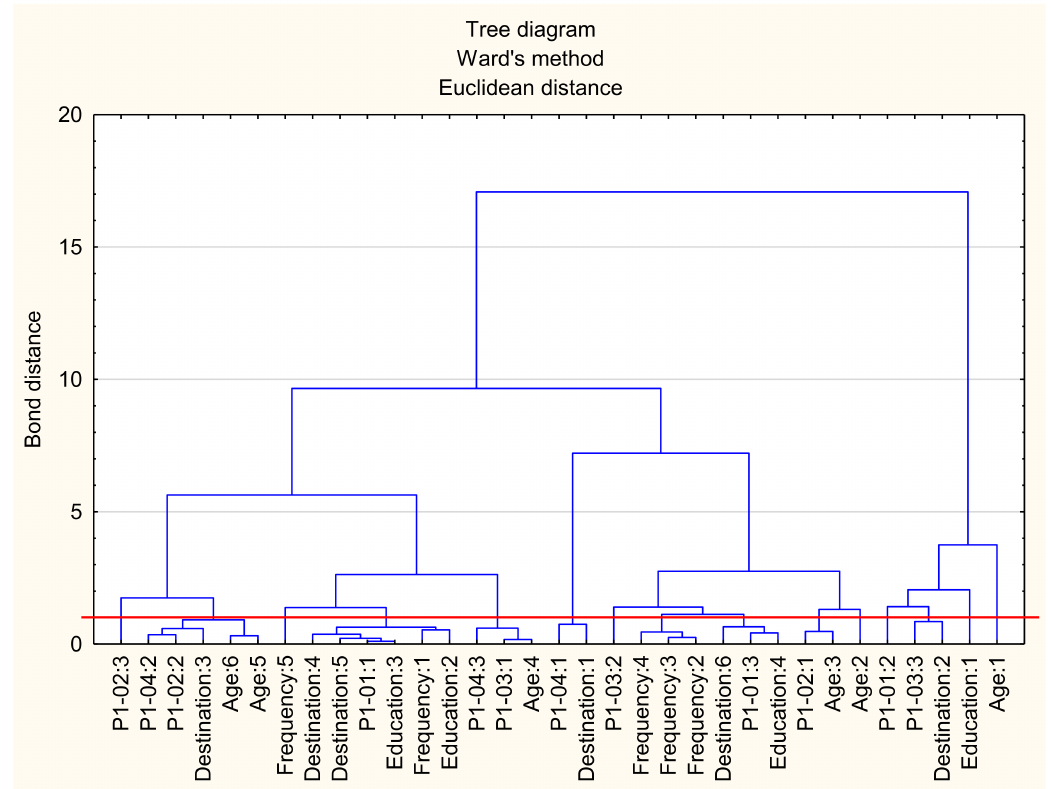
Figure 12. Diagram of hierarchical classification of variable categories—Ward’s